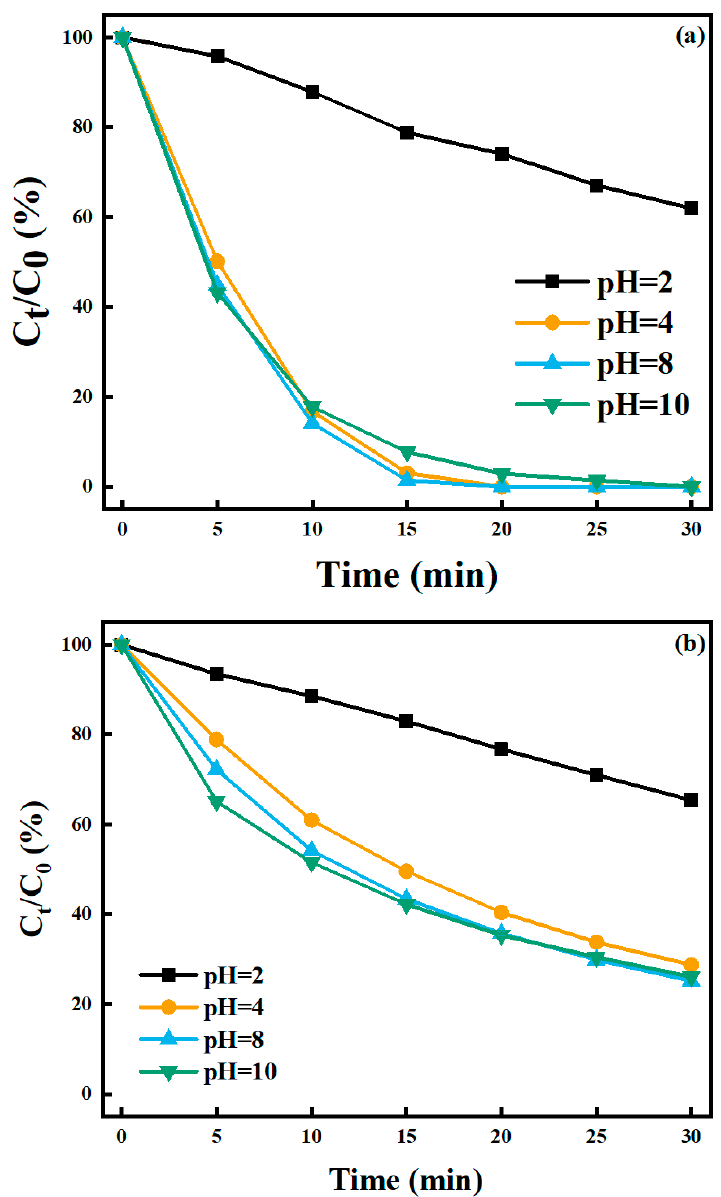
Figure 13. E ff ect of initial pH for MNZ photodegradation by ( a ) Ag / ZnO (100:1) and ( b ) AgI / ZnO Figure 13. Effect of initial pH for MNZ photodegradation by ( a ) Ag/ZnO (100:1) and ( b ) AgI/ZnO (X (X = 0.4) as = 0.4) as catalysts.